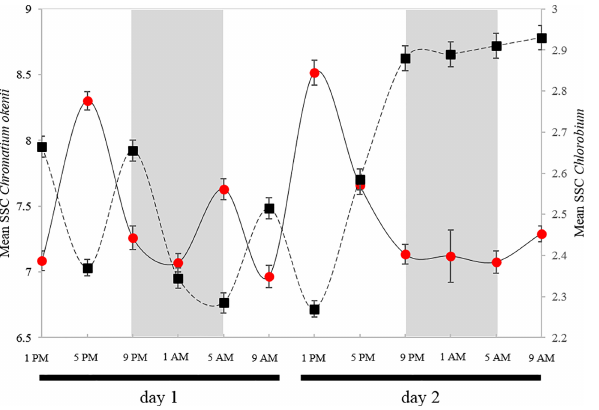
Fig 7. In situ cellular complexity variation of PSB C. okenii and GSB Chlorobium spp . SSC mean values ( × 10 5 ) and 95% CIs for total cells of PSB C . okenii (black squares, dashedlines) and GSB Chlorobium spp. (red circles, solid lines) populations. Analysis was done over two consecutivedays (4 and 5 August 2015) at the depth with maximal cellulardensity (PSB and GSB combined). (Day1: 1PM, 12.8 m; 5PM, 12.2 m; 9 PM, 12.1 m; 1AM, 12.1 m; 5AM, 13.1 m; 9AM, 12.8 m. Day 2: 1PM, 12.1 m; 5PM, 12.5 m; 9PM, 12.6 m; 1AM, 12.9 m; 5 AM, 12.9 m; 9 AM, 12.7 m). Lines represent tentative interpolations